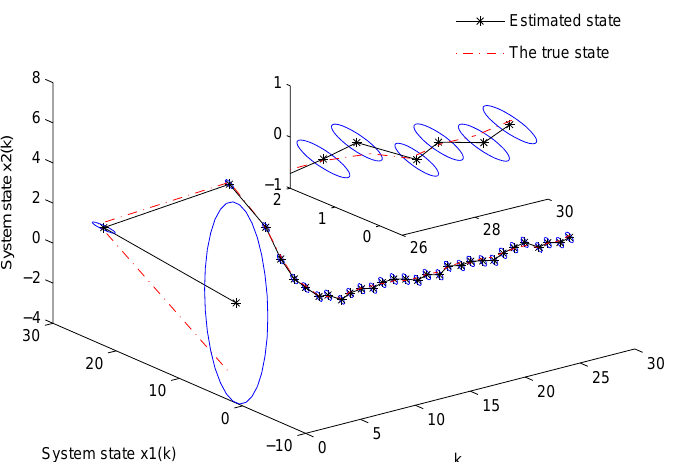
Figure 5. The estimated states and the evolution of the system states feasible sets for the proposed method.